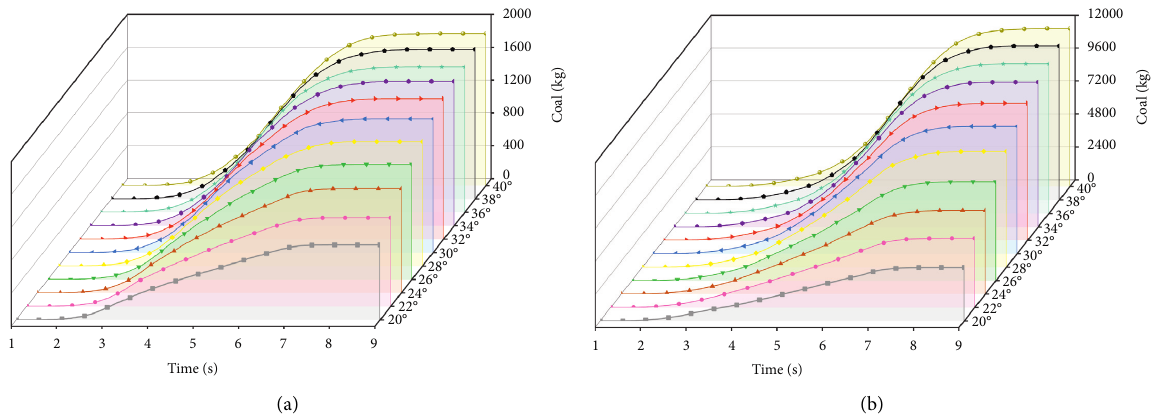
Figure 7: Variation trends of coal and gangue discharge. (a) Variation trend of coal discharge. (b) Variation trend of gangue